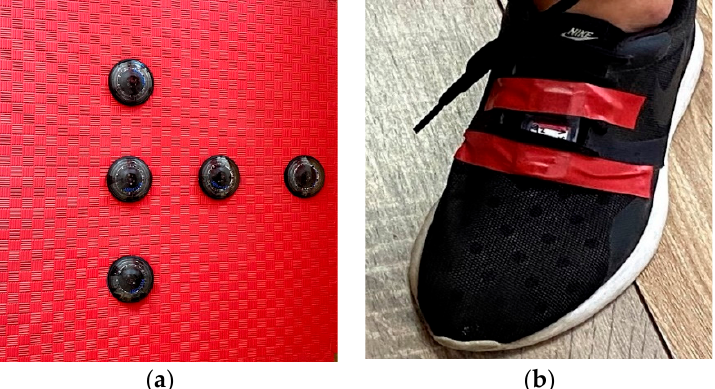
Figure 1. ( a ) FitLight Trainer units positioned and fixed onto foam mat; ( b ) IMU sensor position and orientation on the participant’s shoe. orientation on the participant’s